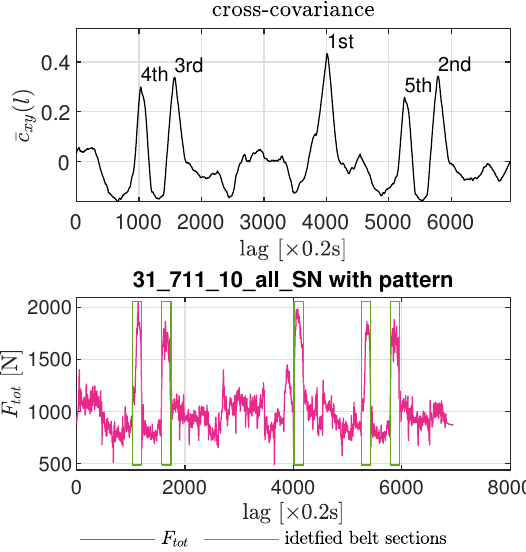
Figure 8: Upper plot normalised cross-correlation between roller force and template function indicating 1st to 5th peak. Bottom plot roller force signal with marked areas of identified belt